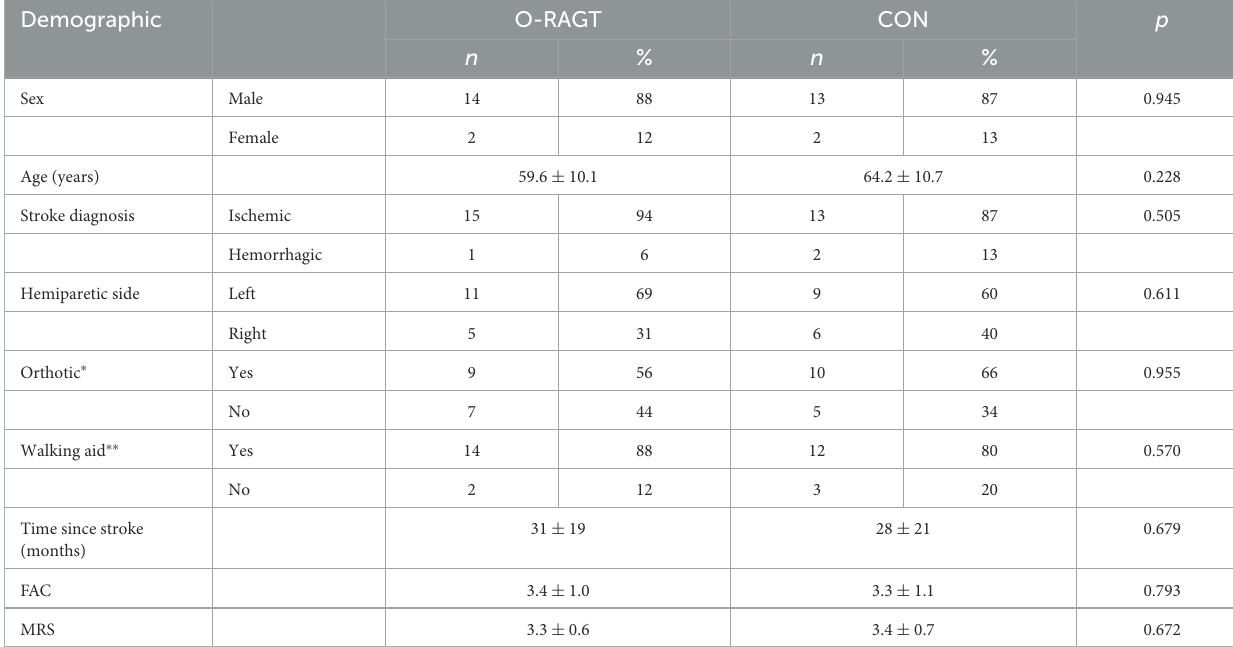
TABLE 1 Participant demographics at